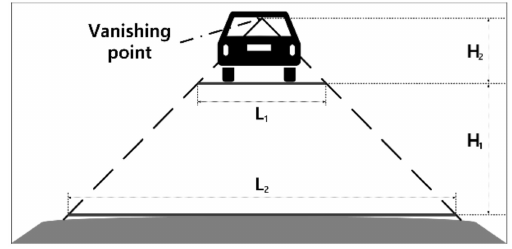
Figure 1. Lane and loss points detected from the image.